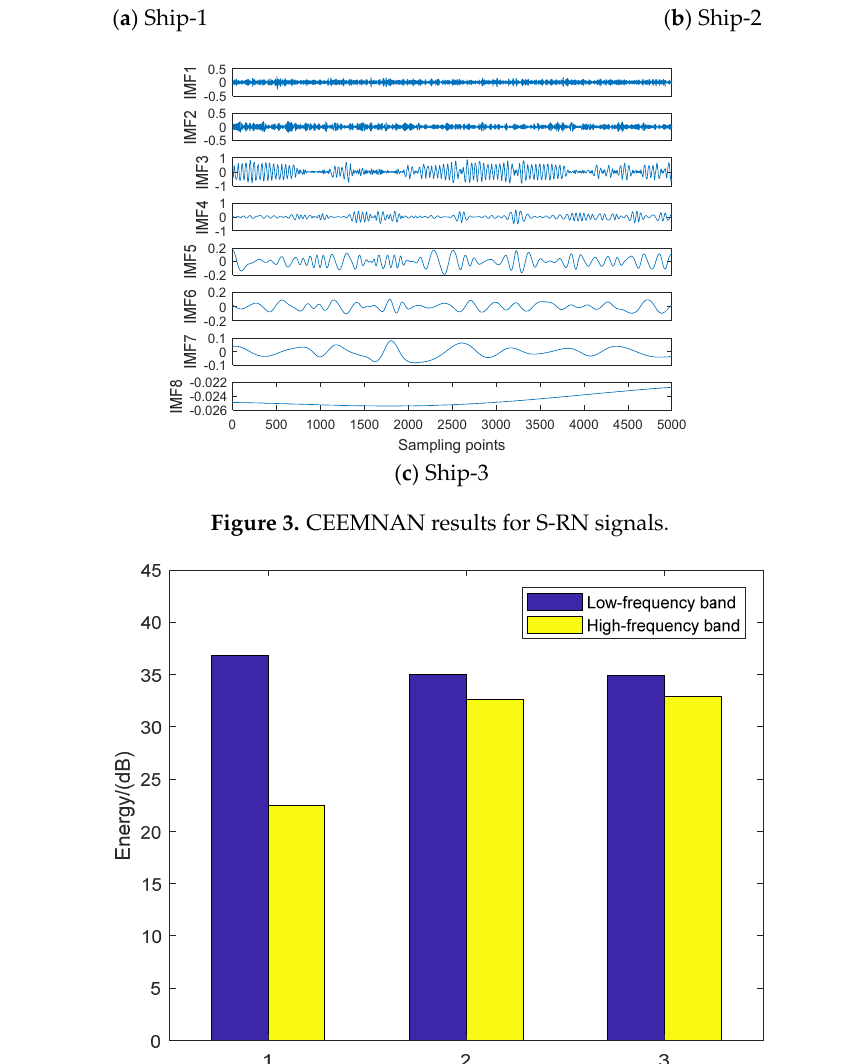
Figure 4. The energy of the low-frequency and the high-frequency band for S-RN signals. Table 1. The ED for S-RN signals. S-RN: ship-radiated noise, ED: energy difference.